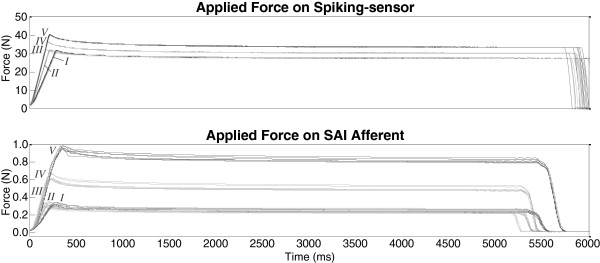
Applied force profiles. All replications of applied force profile traces across five types of indentation (I, II, III, IV, & V) overlaid for the spiking-sensor (top panel) and a mouse SAI afferent (bottom panel) from onset to offset. Both ramp-up rate and hold magnitude were independently varied as indicated by different shapes of the indentation types.